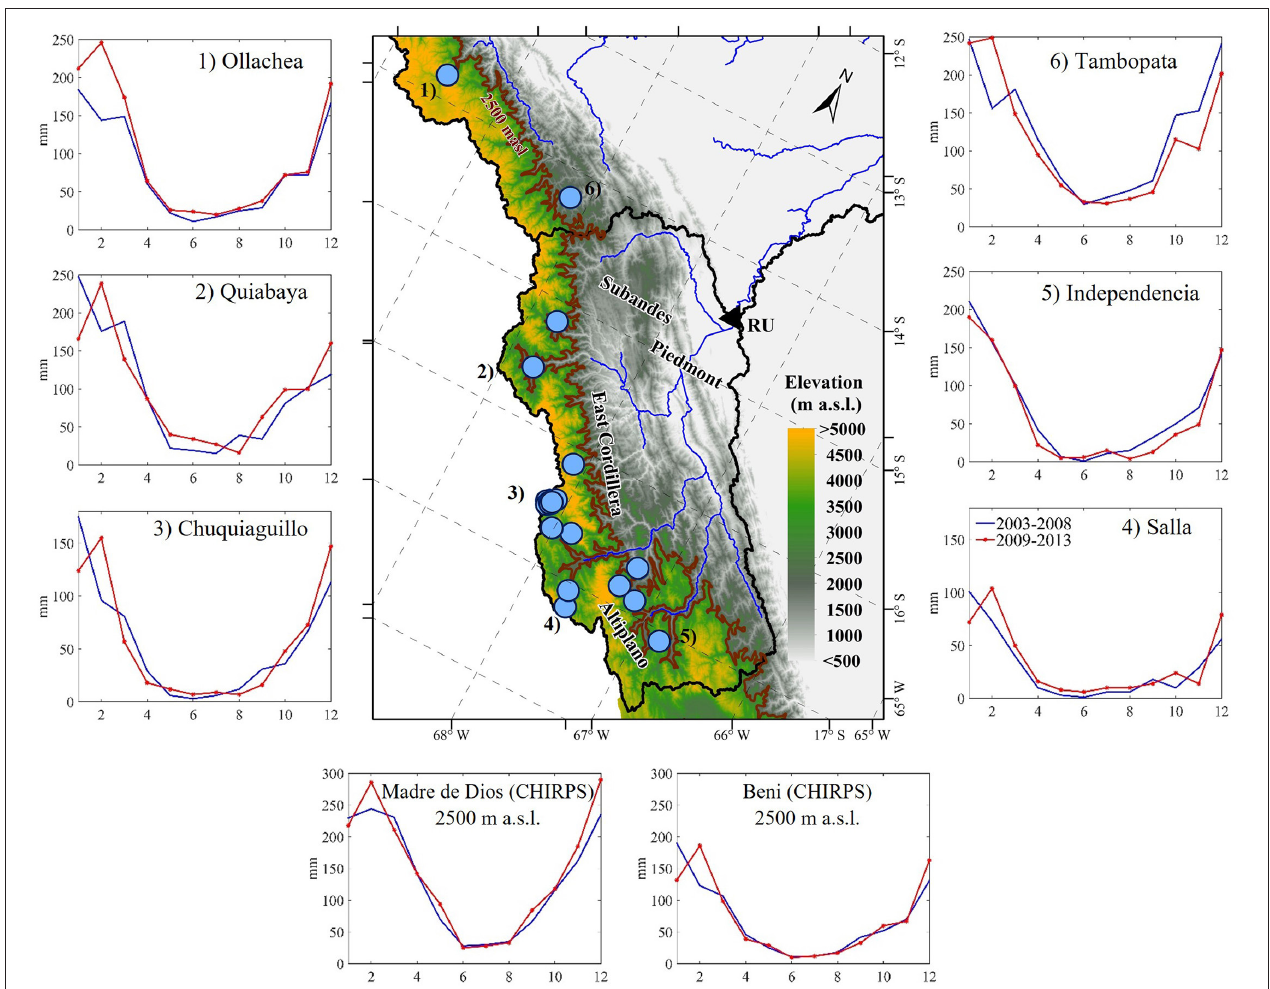
FIGURE 5 | Annual cycle at six of 20 observed stations listed in Table 1 in the Andean region for the two periods, 2003–2008 and 2009–2013 and mean annual cycle for CHIRPS.v2 after the 2500m a.s.l. Note that the y-axis differs according to the magnitude of the rainfall monitored by the stations.